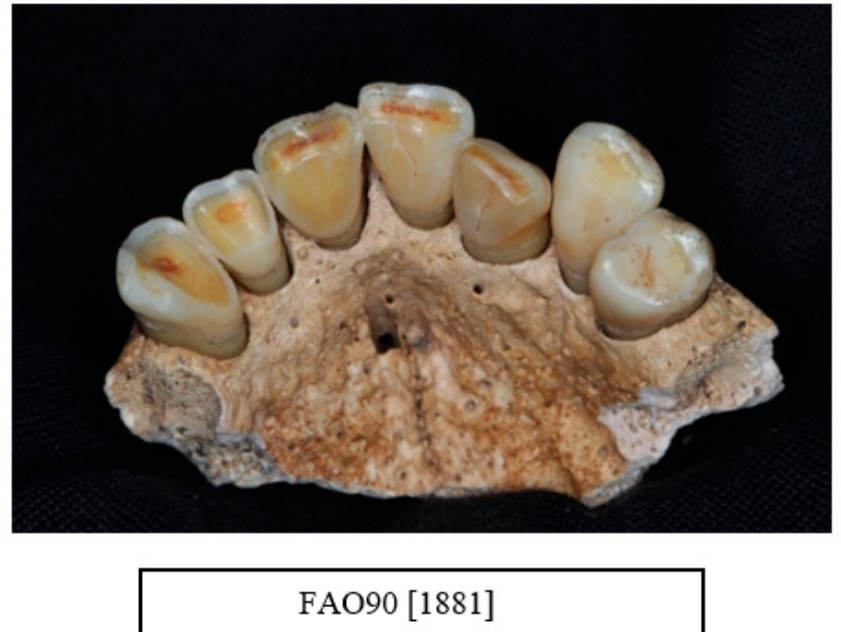
Figure 7. A periapical lesion associated with a retained root of an upper left second incisor tooth (UL2) (courtesy of the Museum of London).